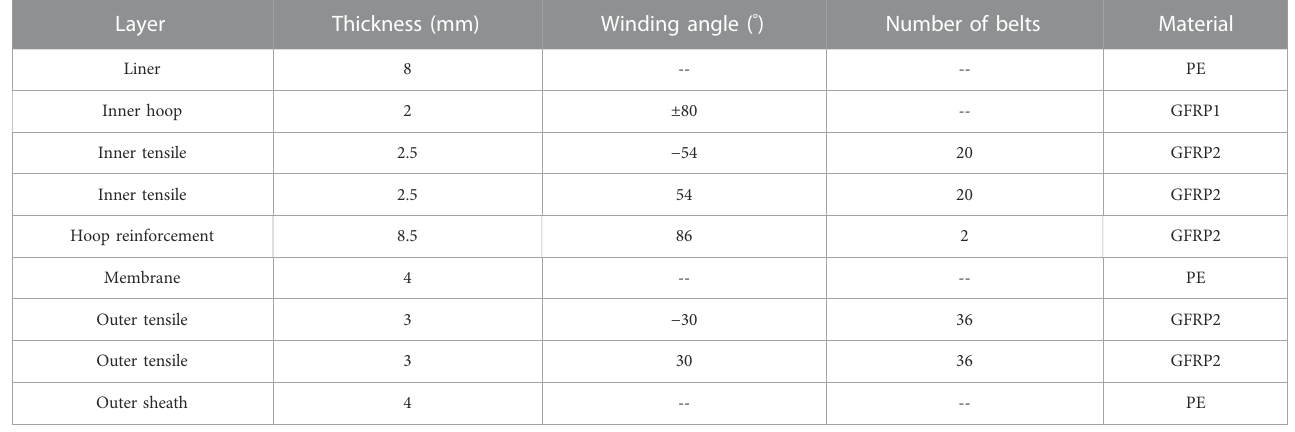
TABLE 1 Geometric parameters and material of each layer. Layer